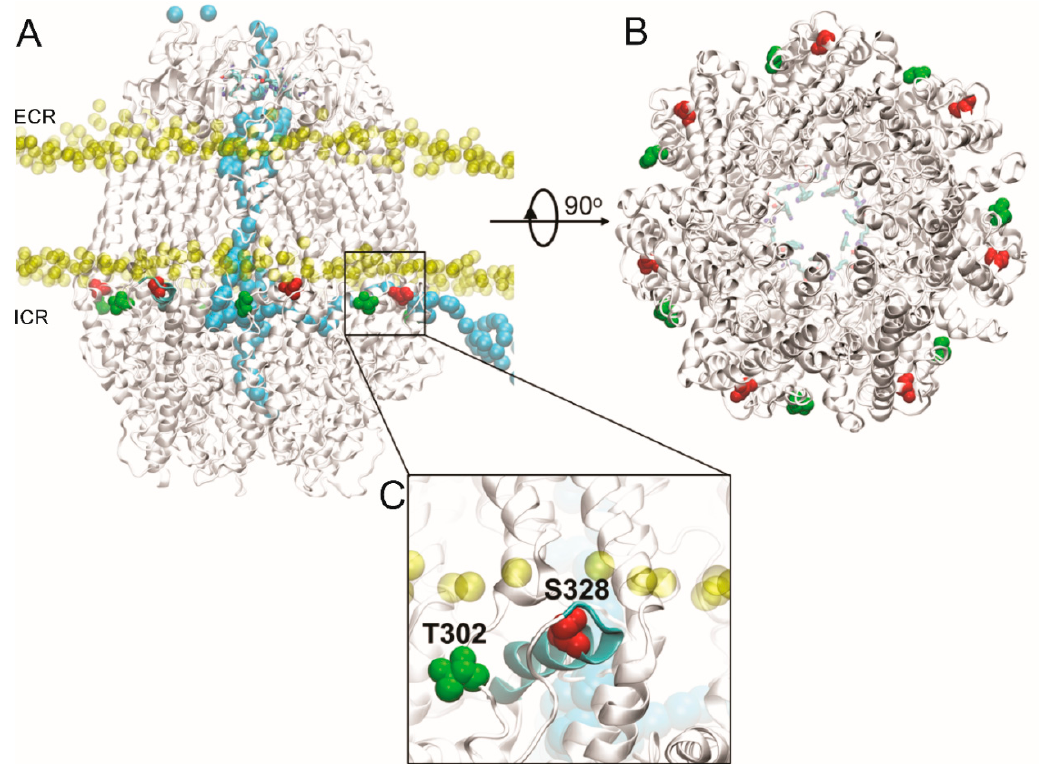
Figure 4. Structural features of putative PKA phosphorylation sites in the Panx1 channel. ( A ) Lateral view of putative PKA phosphorylation sites in Panx1, including the T302 and S328 residues (green and red, respectively), located in the Panx1 C-terminal end. The phosphate atoms of the membrane are shown in yellow. In light blue is shown the trajectory of the Cl − ion crossing the Panx1 channel from the intracellular region, crossing from the lateral tunnel, which is in the inter-subunit interphase, until the main cavity of the pore, then passing until the extracellular region, crossing the selectivity filter (residues W74 and R75 in van der Waals representation). Configuration extracted from molecular dynamics (MD) simulation trajectory. The MD simulation was done using the AMBER force field under an external electric field of ±100 mV. ICR: intracellular region; ECR: extracellular region. ( B ) Intracellular view of the Panx1 channel pore, where the residues of the selectivity filter (show in sticks representation) are observed in the background in blue. The residues S328 and T302 of each segment in the intracellular region of Panx1 are shown in red and green, respectively. ( C ) Close-up view of S328 residue (in red) reveals that it is part of an alpha helix amphiphilic molecule (cyan), which is located in the lipid–water interphase, while the T302 residue (in green) is near to S328, which is inserted into a loop segment.